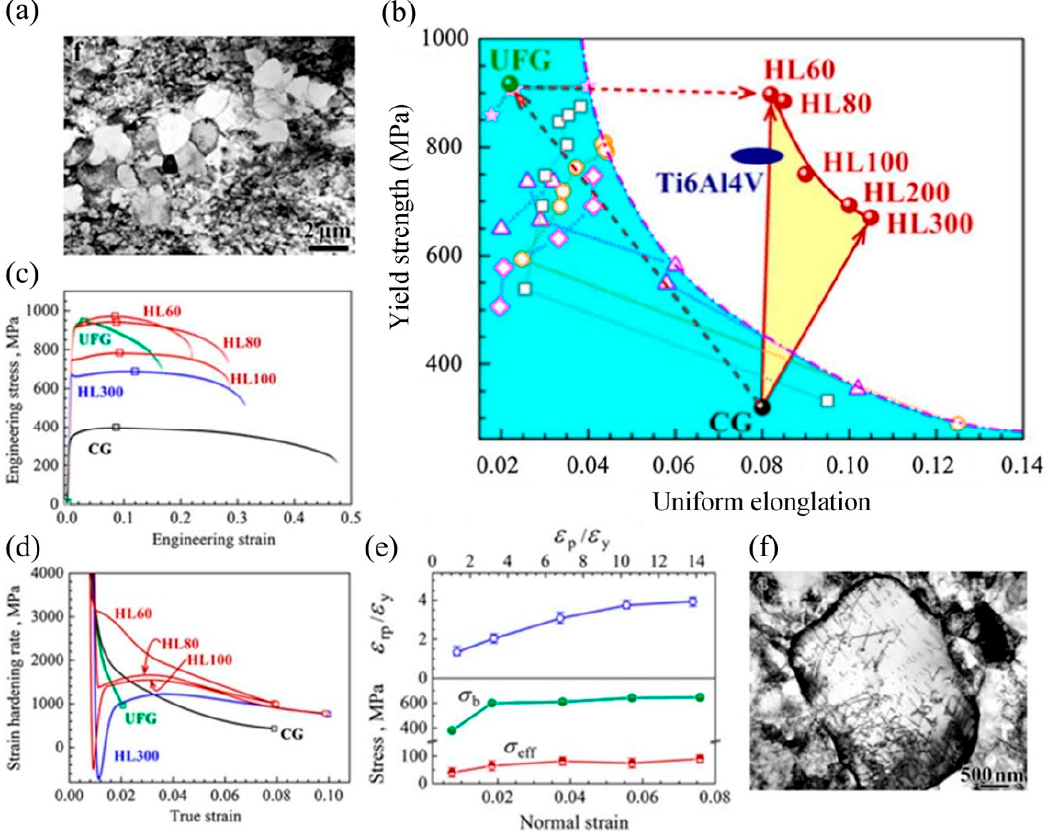
Figure 2. Unprecedented strengthening and extra strain-hardening in Ti with heterogeneous lamella structure (HLS): ( a ) Microstructural characteristics of HLS; ( b ) Outstanding tensile properties of Ti with HLS; ( c ) Engineering tensile stress–strain curves for various samples; ( d ) True strain hardening rate vs. true stress for various samples; ( e ) Back stress hardening behaviors for Ti with HLS; ( f ) Dislocation pile-ups at hetero-interfaces. Adapted from [16].